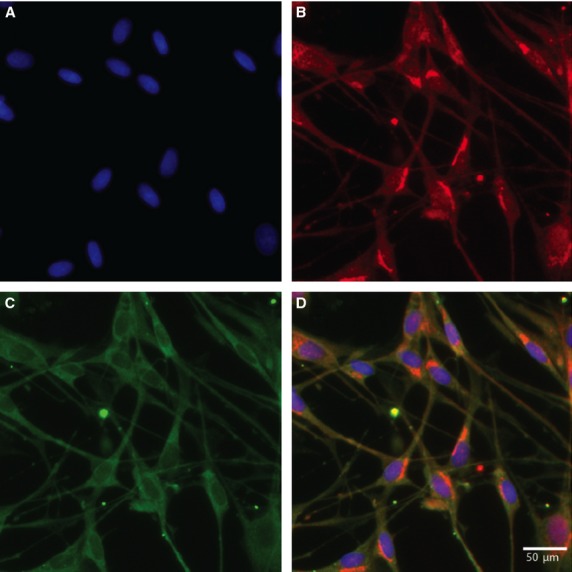
Immunocytochemistry of 7-day-old primary cultures of satellite glial cells from rat trigeminal ganglia. Image (A), shows the nuclei of the satellite glial cell stained with the nuclear stain Hoechst. The cultures are double labelled with antibodies against glutamine synthetase (Red: Alexa fluor® 555) (B) and SNAP-23 (Green: Alexa fluor® 488) (C). The merged image (D) is an overlay of all channels and this image shows the co-localization of glutamine synthetase and SNAP-23 in cultured rat trigeminal satellite glial cells. Virtually all SGCs seem SNAP-23 positive.